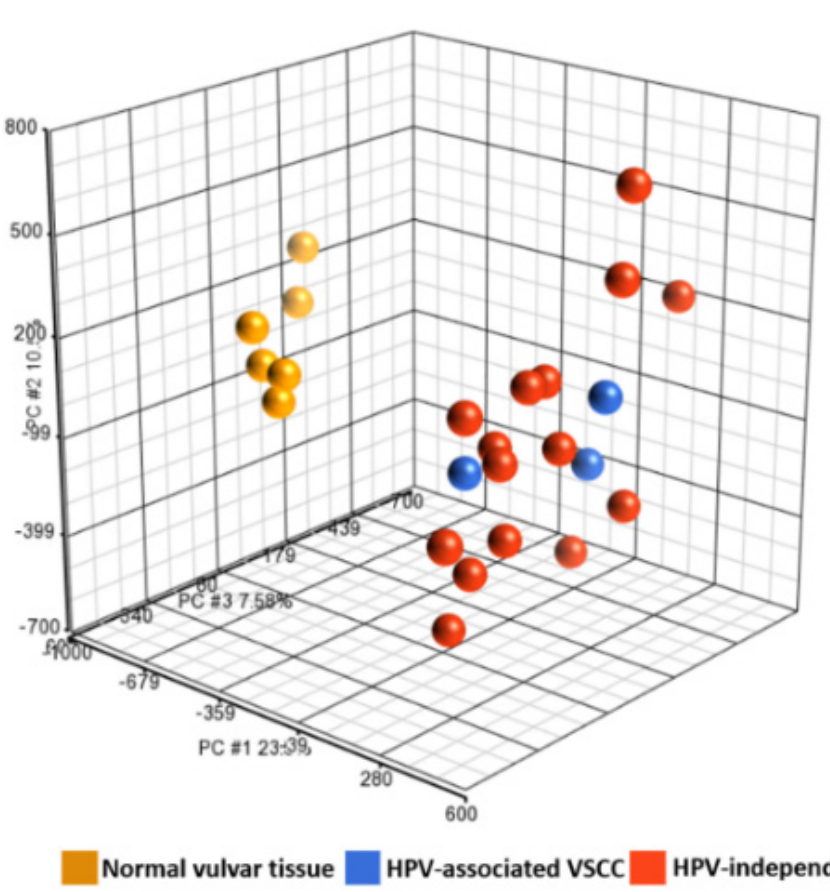
Figure 1. Principal component analysis of the differentially methylated probes shows clear clustering for VSCCs and normal vulvar tissues.